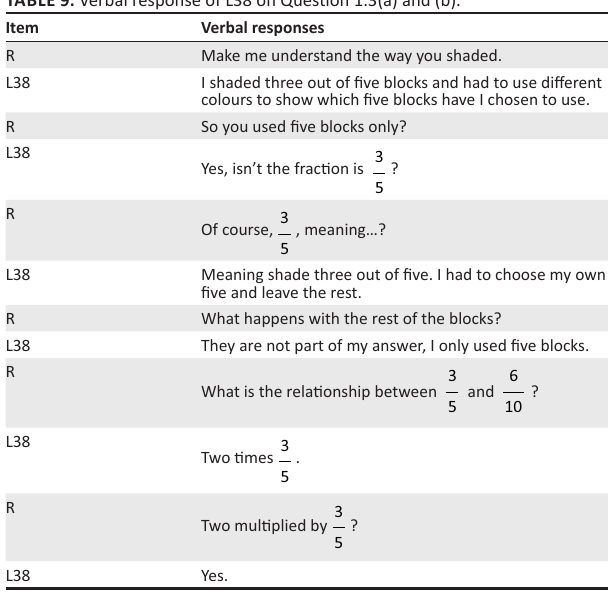
TABLE 8: Verbal response of L34 on Questions 1.3(a) and (b). Item Verbal responses R Make me understand the way you shaded. L34 I shaded three blocks on top of five blocks, three blocks over five blocks. R Why? L34 3 seen indicating TABLE 9: Verbal response of L38 on Question 1.3(a) and (b). Item Verbal responses